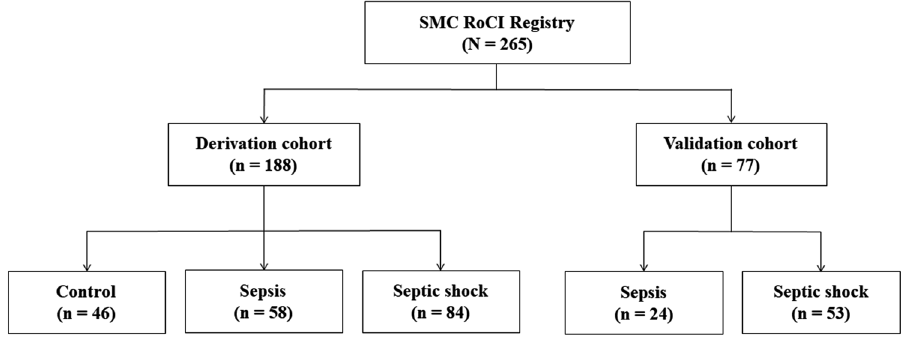
Figure 1. Flow diagram of studied patients (SMC-RoCI, Samsung Medical Center Registry of Critical